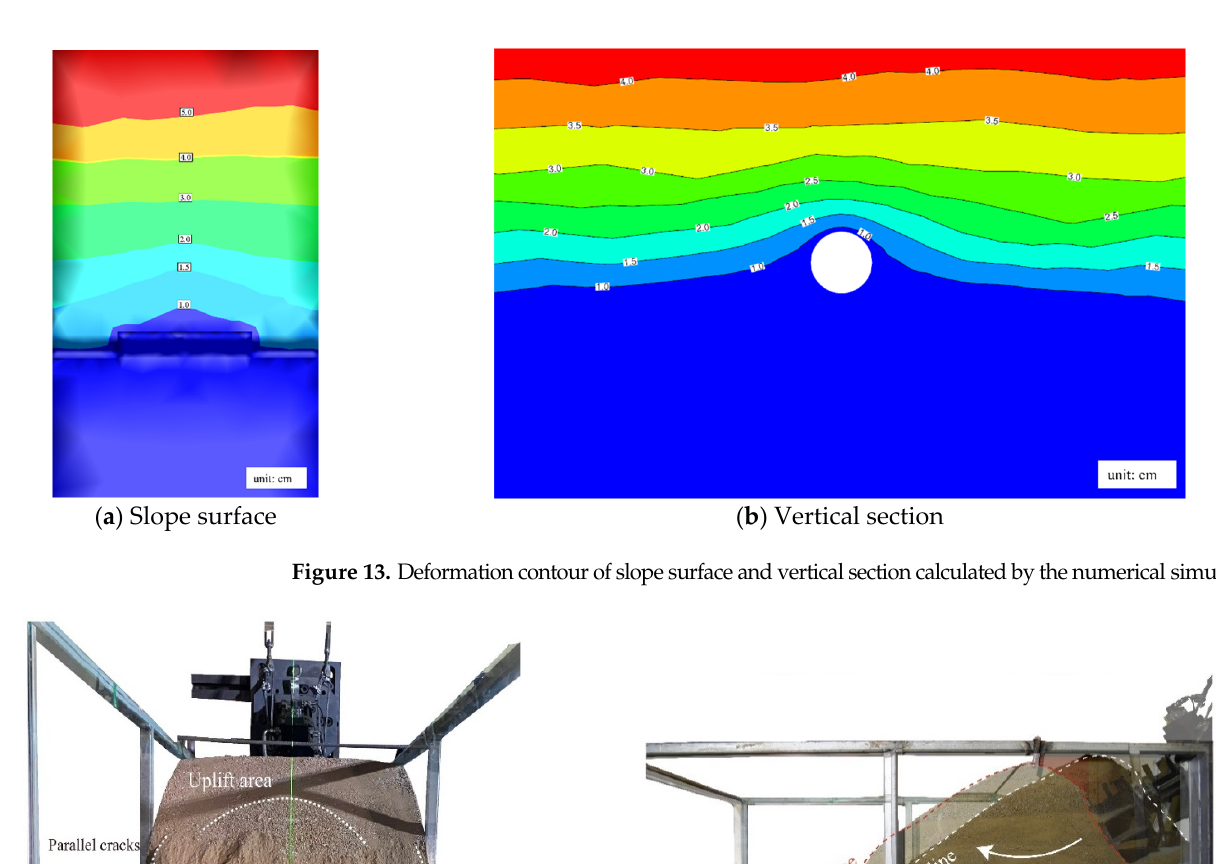
Figure 14. Deformation characteristics of the slope at the end of the test loading.